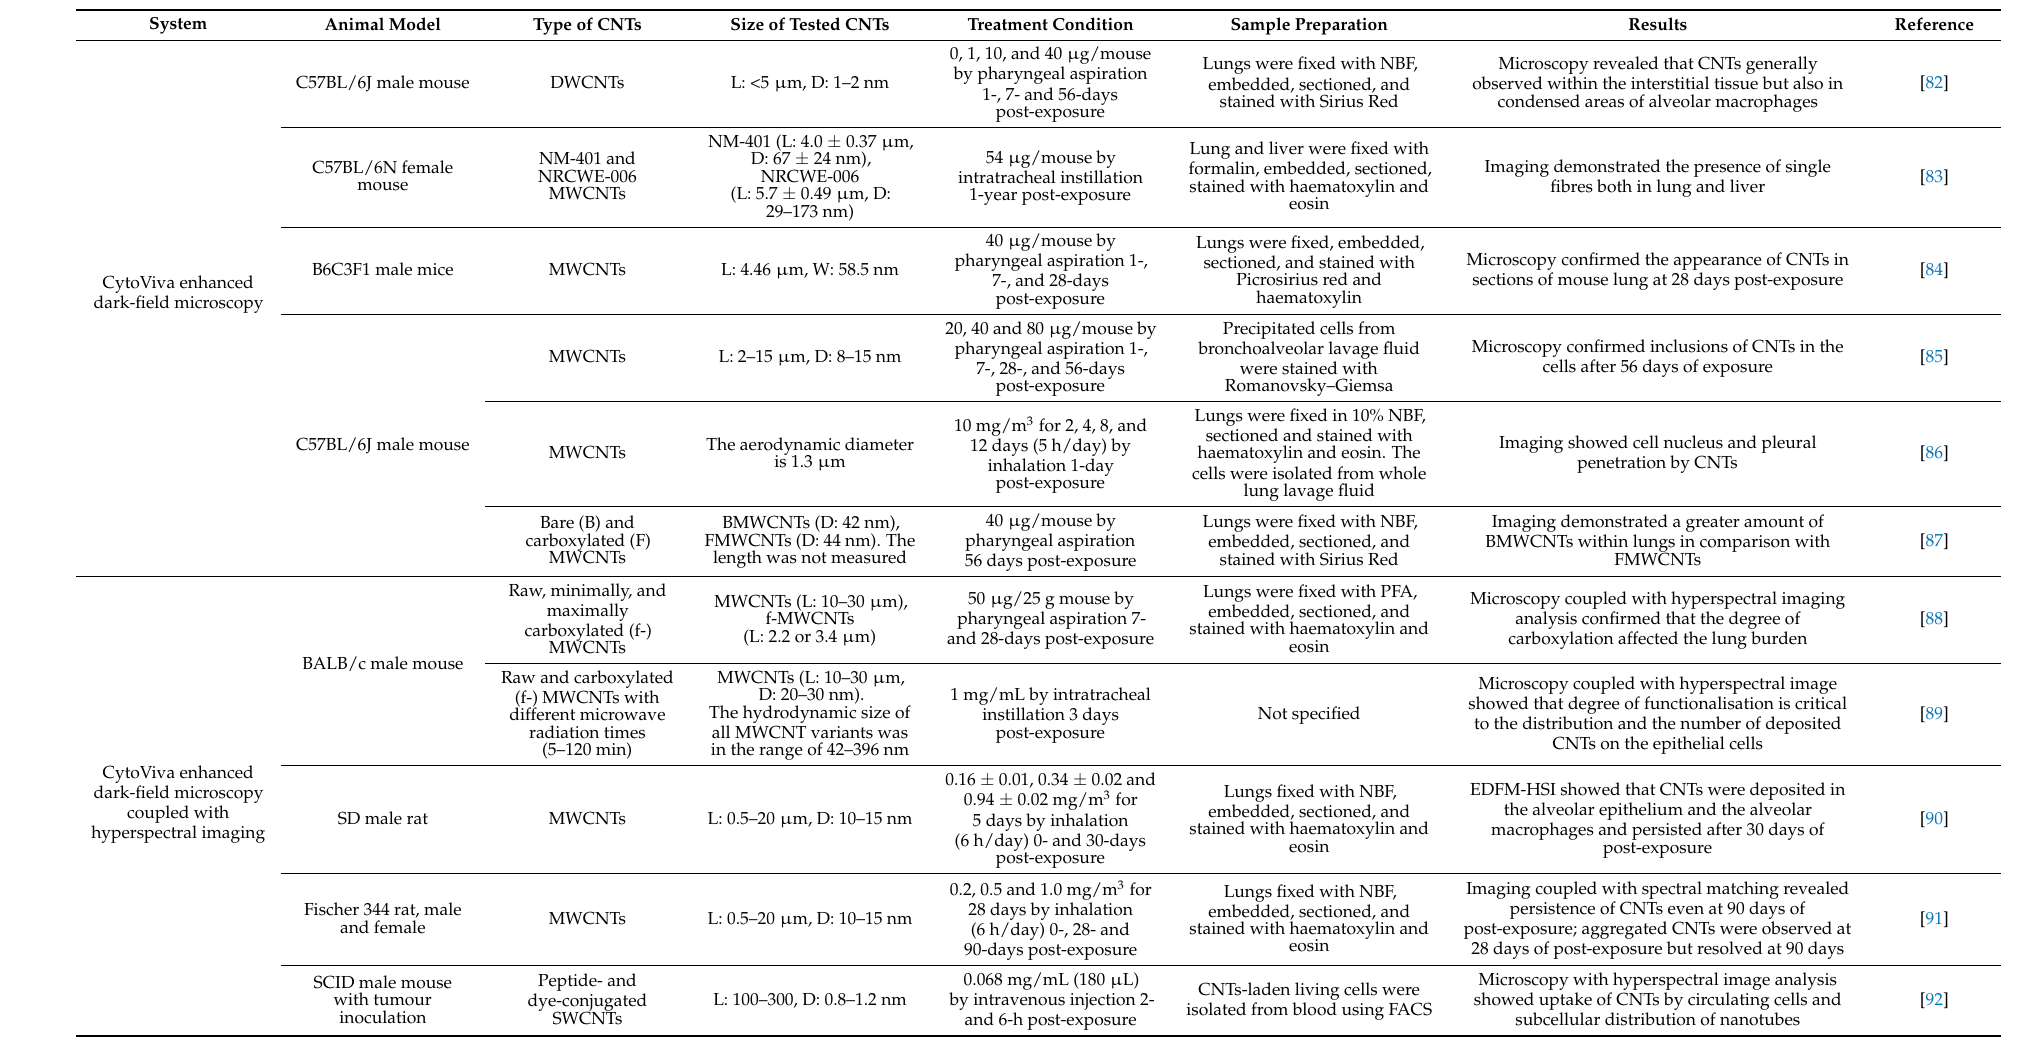
Table 2. Overview of in vivo studies of carbon nanotubes applied dark-field imaging technique. L—length; D—diameter;